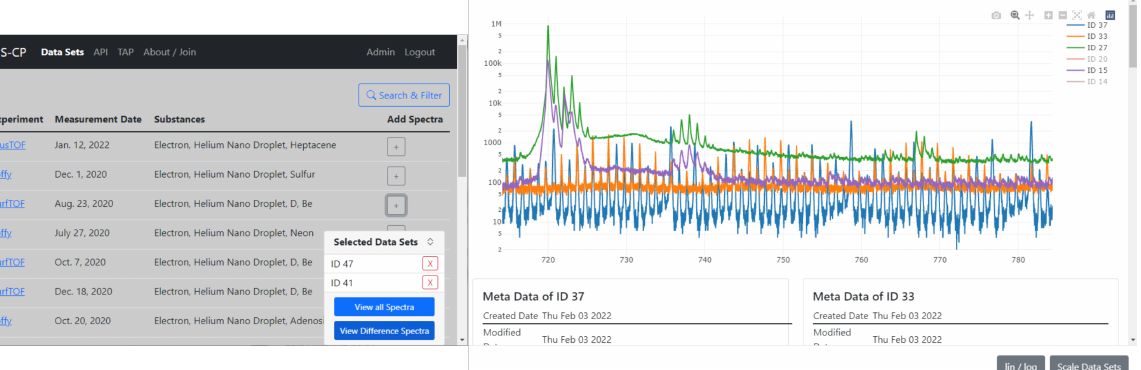
Figure 1. Screenshots of the GUI. Left: List of available datasets with the option to search and filter the entries. Selected datasets can be viewed on top of each other or as a differential mass spectrum (see Figure 2). Right: data representation. The upper part contains the visual representation of the selected datasets, the lower part shows metadata of the selected datasets. At the bottom, two buttons allow for the toggling between a linear and a logarithmic ion yield axis as well as the scaling of the individual mass